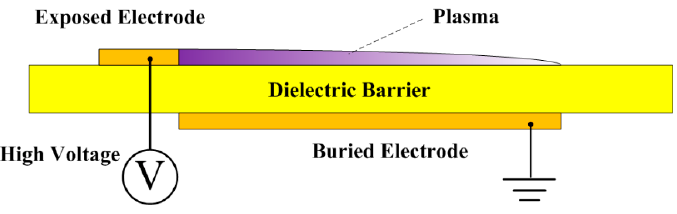
Figure 1. Sketch of a DBD plasma actuator.